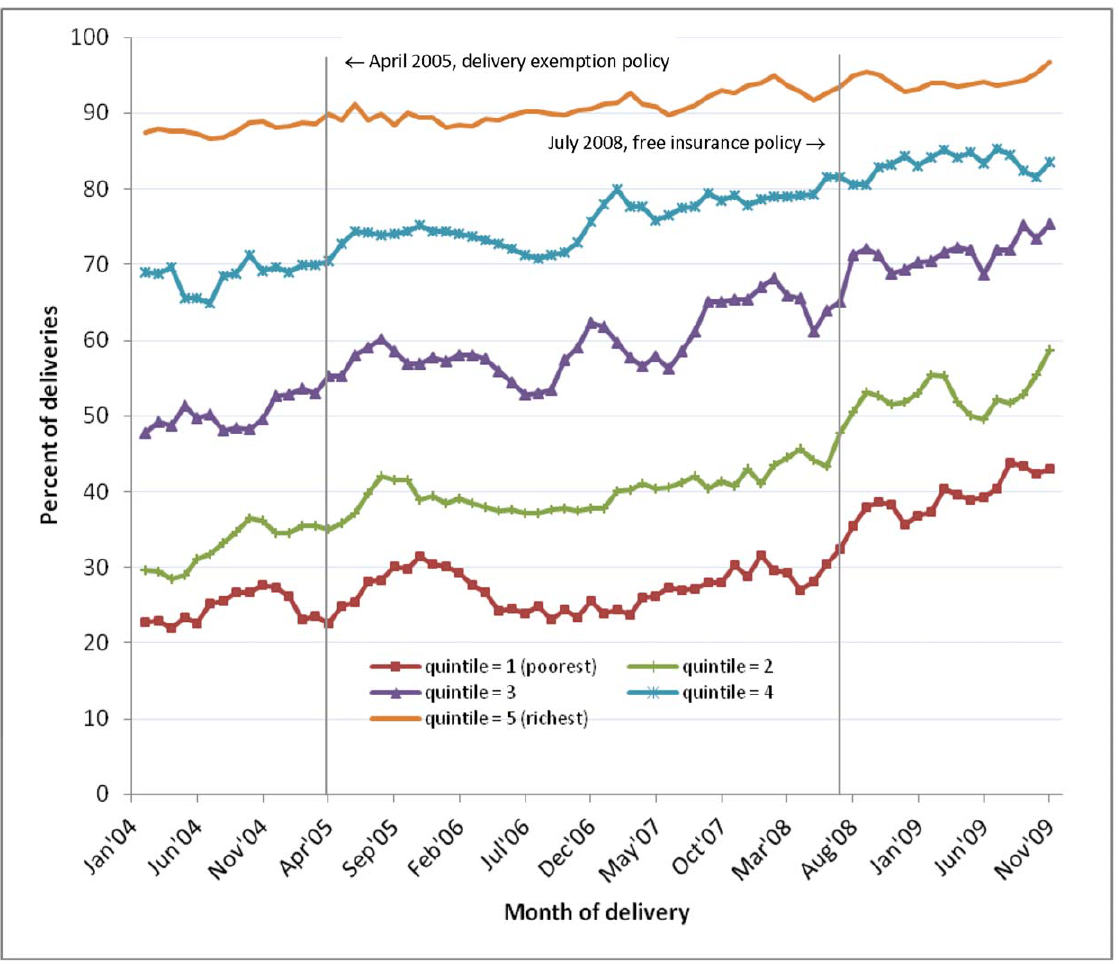
Figure 3. Facility deliveries, January 2004–December 2009: by wealth quintile (simple 3-month moving averages). Figure shows the percentage of deliveries occurring in a facility each month within each wealth quintile.